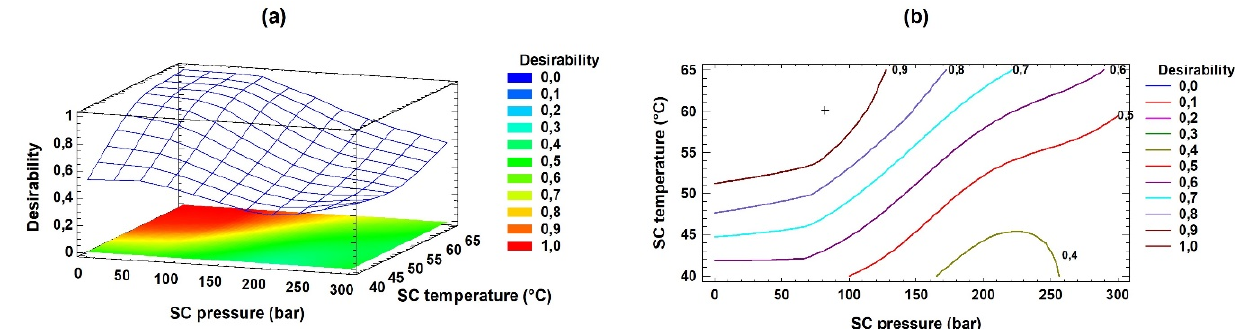
Figure 3. Response surface and contouring graphs showing the multi-response optimization of EPA, DHA, AP, EPA + DHA, and EPA/DHA in sn -2 (SC, supercritical conditions). Panels: ( a ) desirability function; ( b ) contours of estimated response surface.